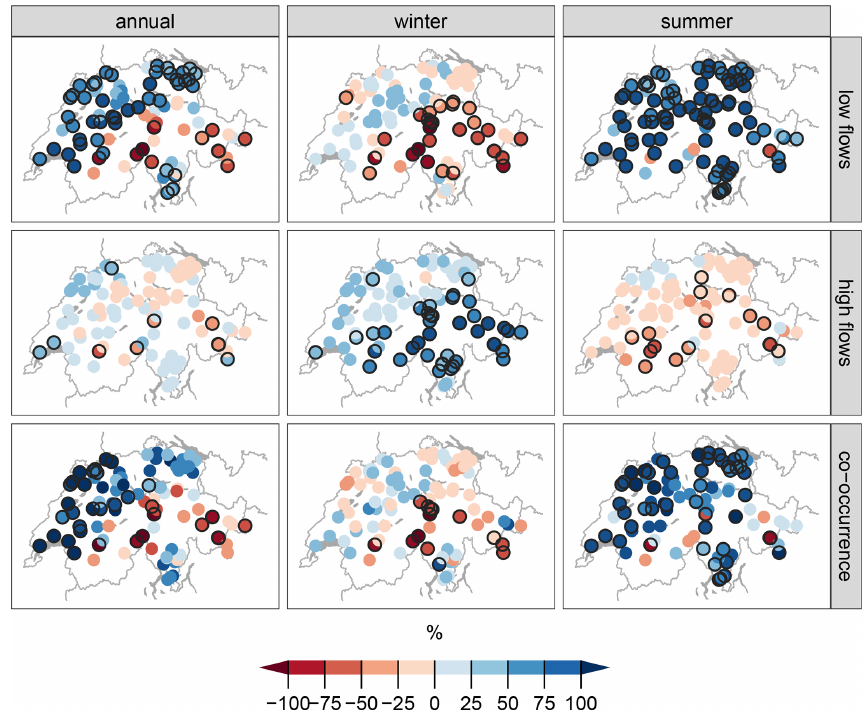
Figure 9. Relative changes in the frequency of occurrences of moderate low-flow events (lower than the median of the reference period, top panels), of moderate high-flow events (higher than the median of the reference period, middle panels), and co-occurrence of low- and high-flow events (bottom panels) by the end of the century. Black circles indicate changes with at least 90% of the models agreeing on the direction of